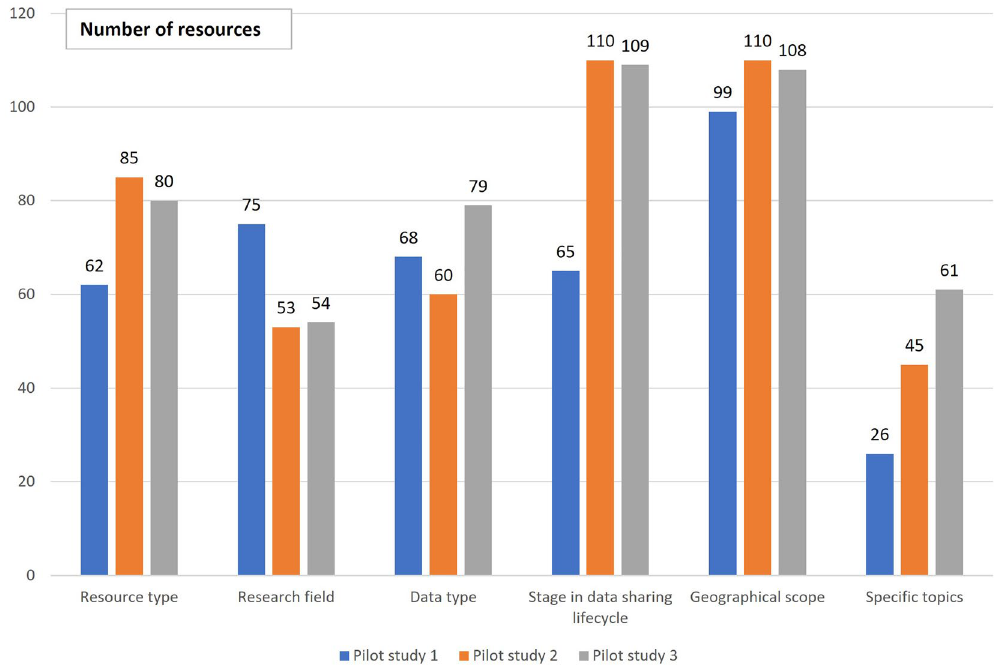
Figure 3. Number of resources tagged with only one tag per category for the categories applied in all three pilot